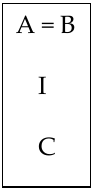
Figure 1. A basic whakapapa sequence.